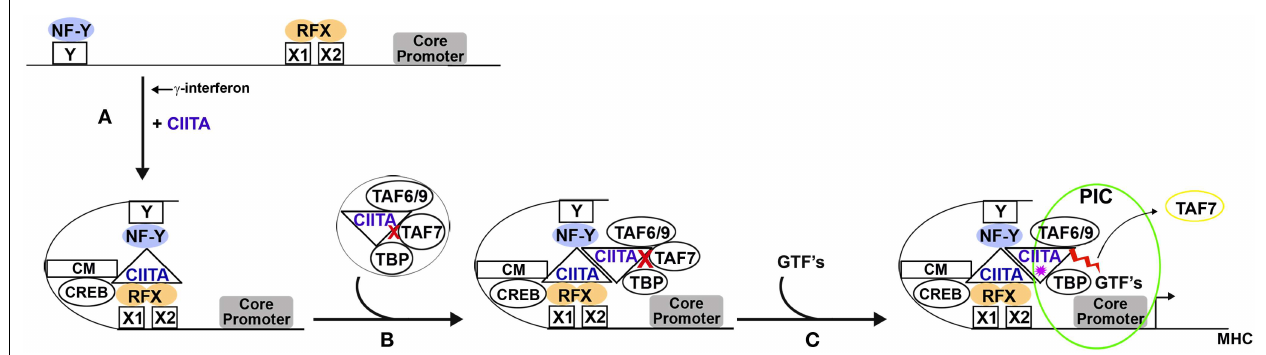
TAF6/9,TAF7, andTBP.The CIITA in theTFIID-like complex is recruited to and dimerizes with the CIITA present at the enhanceosome.TAF7 keeps the acetyltransferase activity of CIITA in check during this process ( ). (C) The arrival of other general transcription factors (GTFs) completes assembly of the pre-initiation complex, leading to autophosphorylation of CIITA ( ). CIITA autophosphorylation triggers the release ofTAF7 and reveals the AT activity of CIITA ( ), allowing transcription to